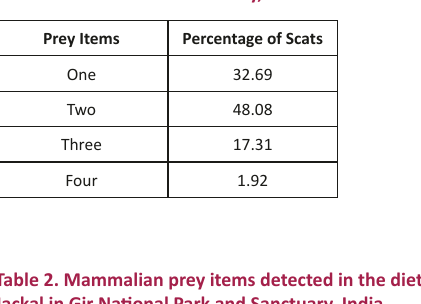
Large mammals Small mammals Plant species Prey group Figure 3. Prey group frequency of occurences in the scat of the Golden Jackal in Gir National Park and Sancturay, India. [Large mammals (buffalo, cow, chital, sambar, langur and bluebull); Small mammals (hares and rodents); Plant species ( Zizyphus and Caparis ); Waste (plastic and